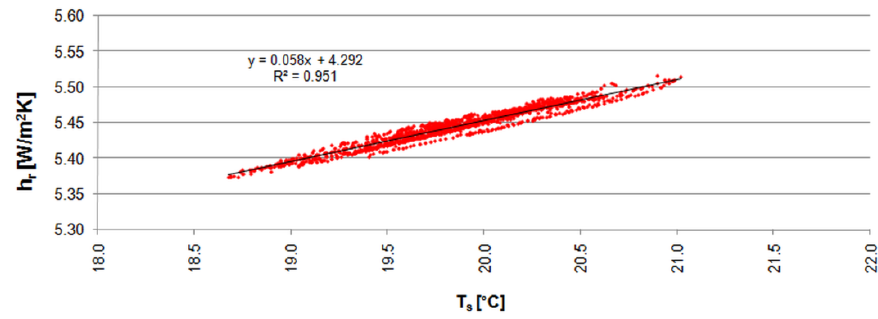
Figure 6. Radiative heat transfer coefficient from measurements.